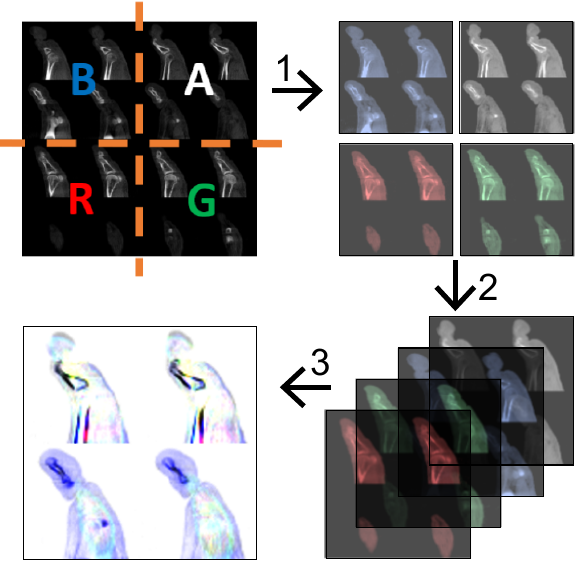
Figure 6. From left to right : (1) Slicing the image into 4 parts, each corresponding to a color channel, (2) Combining each part into one smaller RGBA image, (3) The resulting image is 4 times smaller in size than the original.